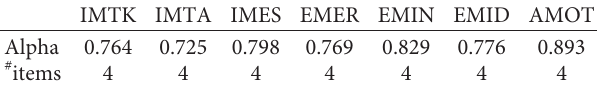
Table 1: Alpha coefficient for the study’s